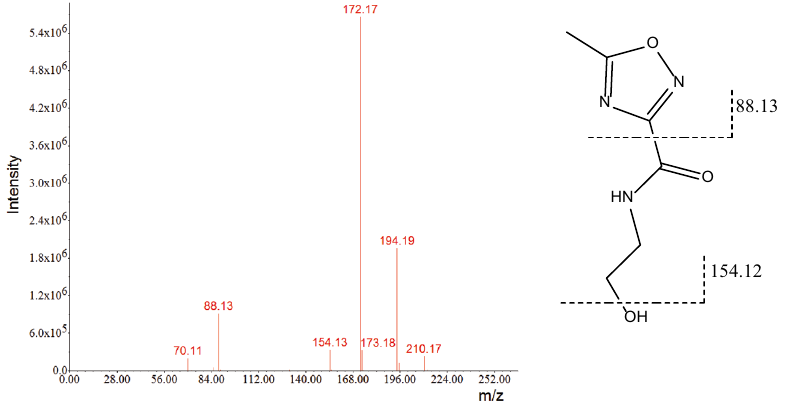
Figure 2. MS spectrum of the major photodegradant of metronidazole. ([M + H] + m / z 172.17, [M + Na] + m /